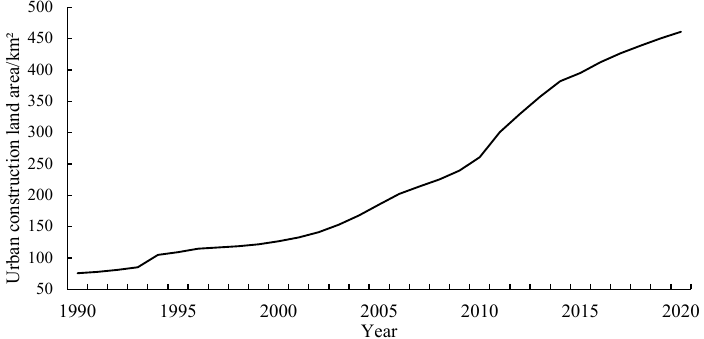
Figure 2. Quantity Change of urban land in Nanchang city from 1990 to 2020.